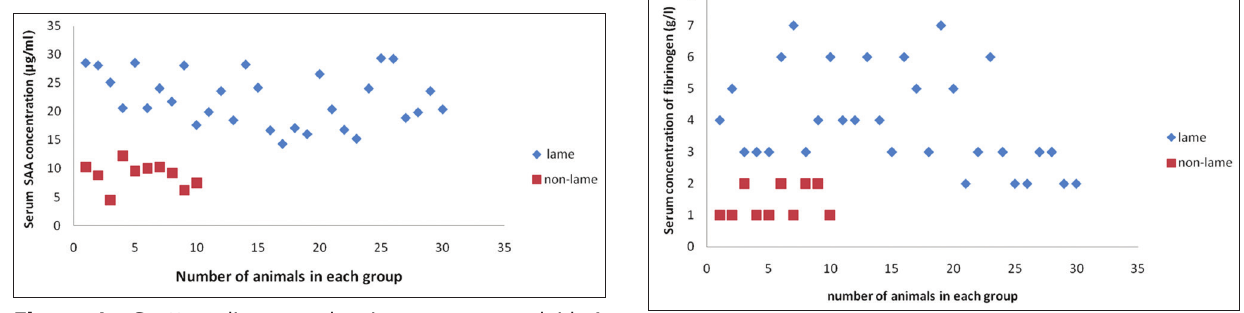
Figure-3: Scatter diagram showing fibrinogen concentration in lame and non-lame healthy crossbred cows.